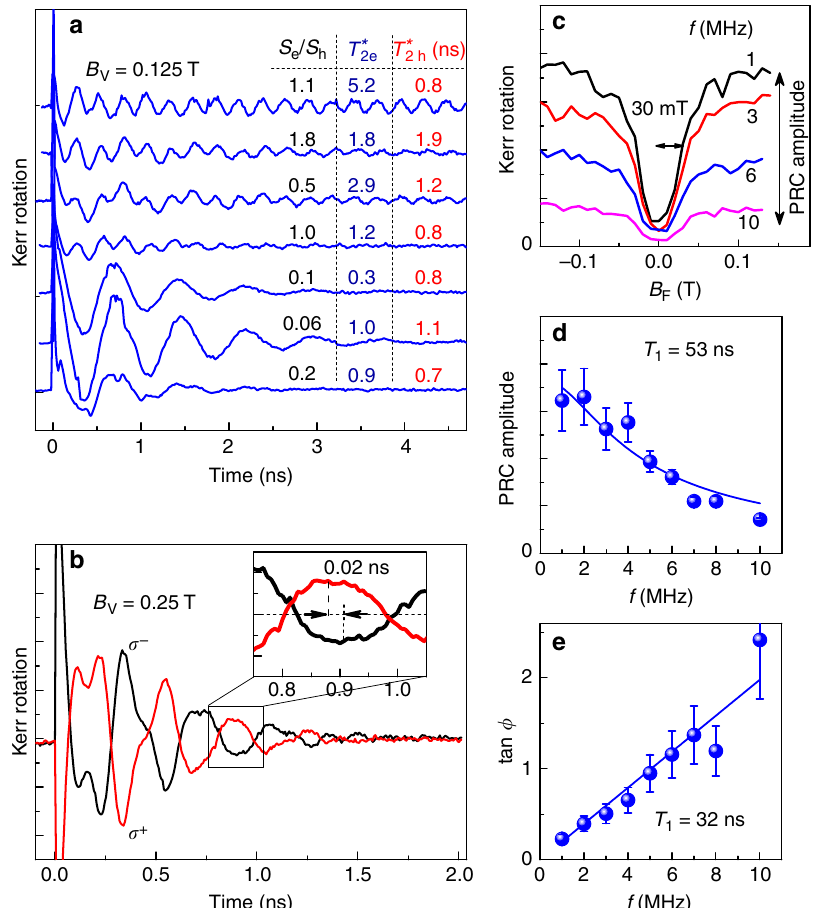
Fig. 3 Carrier-nuclei hyper fi ne interaction and evaluation of longitudinal spin relaxation time T 1 . a Spin dynamics at different positions on sample, B V = 0.125 T and T = 10 K. b Dynamics of Kerr rotation for different circular polarizations of pump pulses. Inset illustrates phase shift acquired for hole spin precession. T = 5 K. Pump is tilted from normal incidence by an angle of 15°. c Polarization recovery curves (PRCs): dependencies of Kerr rotation signal on longitudinal magnetic fi eld at time delay Δ t = 13 ns, measured for different pump modulation frequencies. T = 2 K. d Modulation frequency dependence of PRC amplitude. Line is fi t to data with Equation (2) giving T 1 = 53 ns. e Modulation frequency dependence of tan ϕ , where ϕ is phase retardation of Kerr rotation signal with respect to pump modulation. Line is linear fi t tan ϕ = 2 π fT 1 with T 1 = 32 ns. Error bars represent the standard deviations. Source